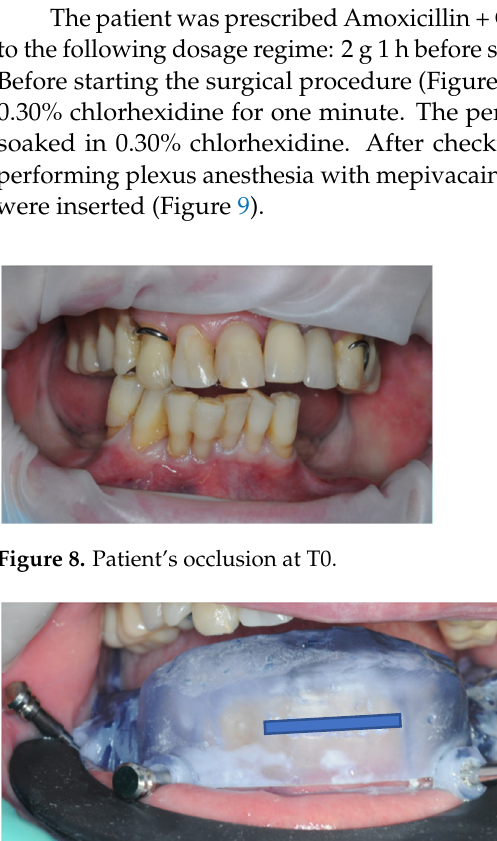
Figure 7. 3D-printing preview of the provisional prosthesis.